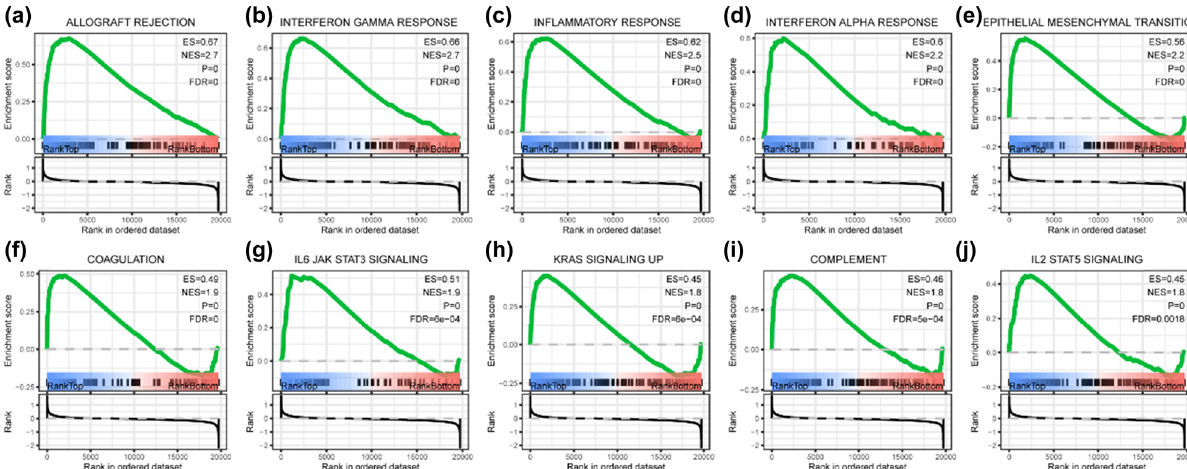
Figure 10: Top enriched hallmark gene sets between high and low - risk groups determined by GSEA: ( a ) allograft rejection, ( b ) interferon - gamma response, ( c ) in fl ammatory response, ( d ) interferon - alpha response, ( e ) epithelial – mesenchymal transition, ( f ) coagulation, ( g ) IL6 JAK STAT3 signaling, ( h ) Kras signaling up, ( i ) complement, and ( j ) IL2 STAT5